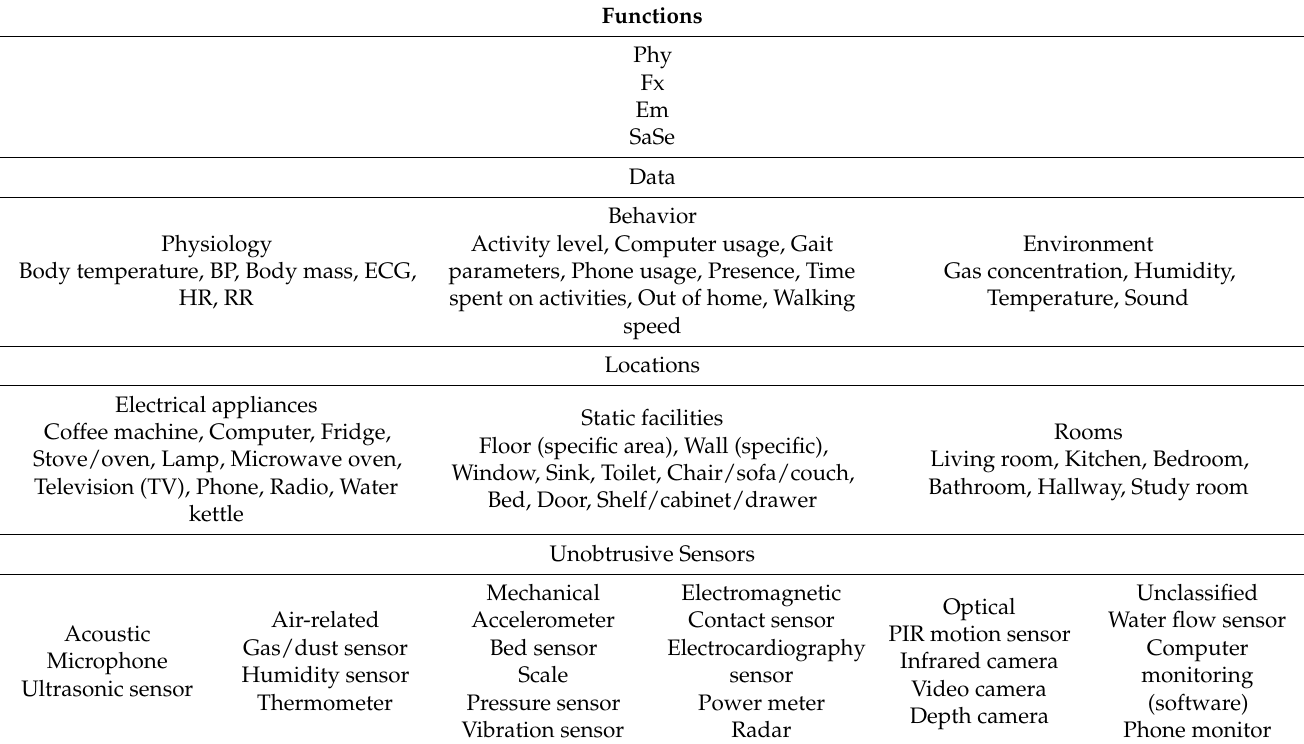
Table 7. Environmental Signals, retrieved from: Wang et al. 2021 [24,34].